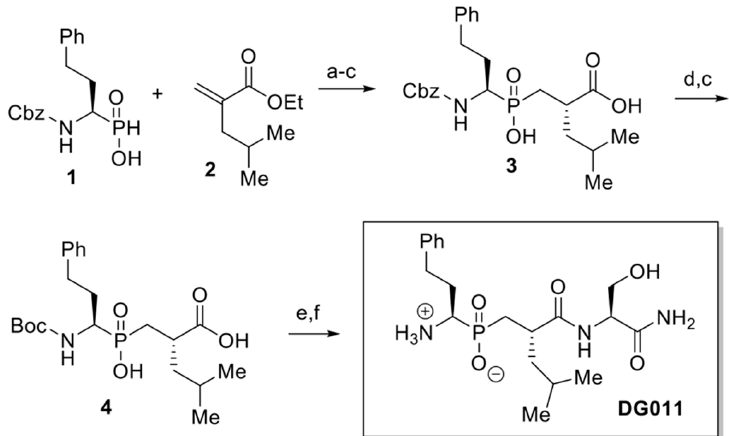
Figure 5. Synthetic strategy for DG011. (a) HMDS, 110 ◦ C, 1 h, then 90 ◦ C, 3 h, then EtOH, 70 ◦ Figure 5: Synthetic strategy for DG011. (a) HMDS, 110 °C, 1 h, then 90 °C, 3 h, then EtOH, 70 °C, 30 min; (b) aq. NaOH, EtOH, rt, 24 h, then H 3 O+; (c) 2 × recrystallizations by AcOEt, 46%, three steps;